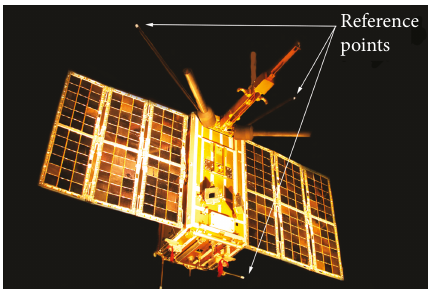
Figure 3: Microsatellite “ Chibis-M ” and the reference